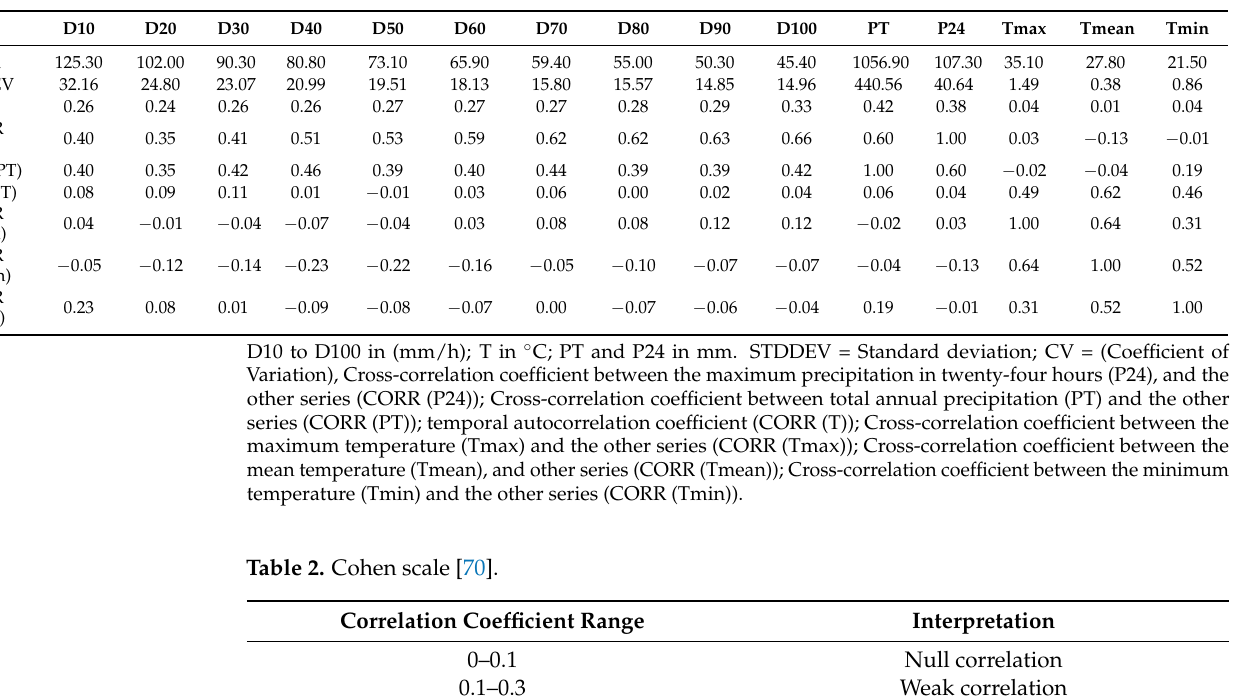
Table 1. Descriptive statistics of each of the series under study.